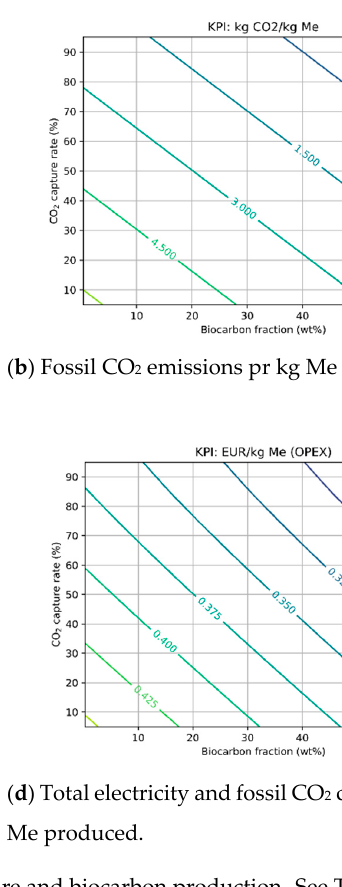
Figure 11. FeSi production with integrated CO 2 capture and biocarbon production. See Tables 2 and 3 for design parameters.